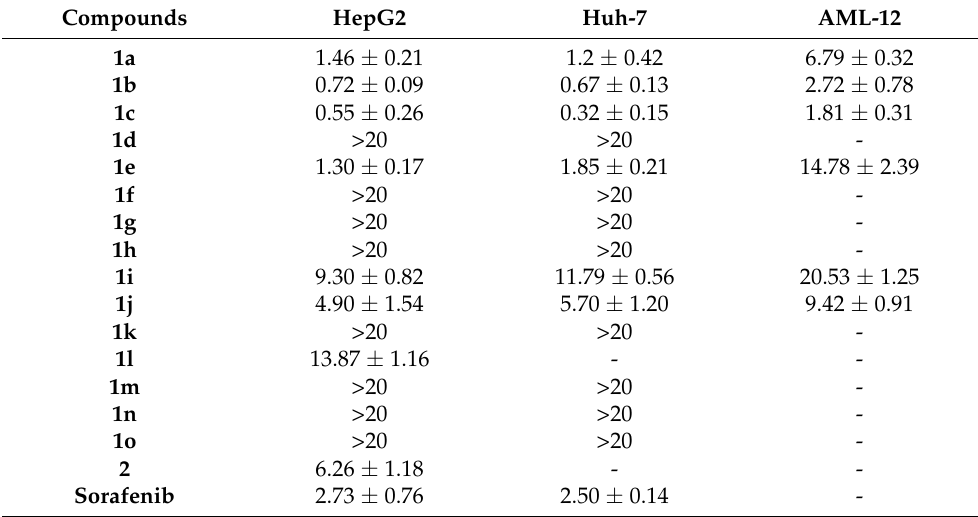
Table 1. Anti-proliferative activity expressed as IC 50 ( µ M) 1 of test compounds 1a – o and 2 against human HepG2 or Huh-7 hepatoma cell lines and non-malignant murine AML-12 hepatocytes after 48 h (sorafenib was used as positive control).